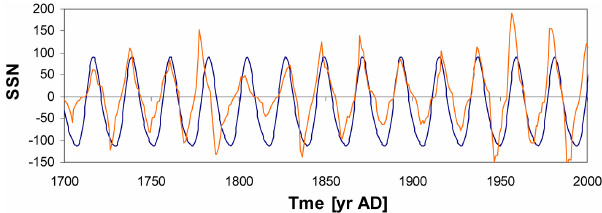
Figure B4. The double integral of the solar lateral inertial forces σF 2 ( t ) for the period from AD1000 to 3000. A polynomial trend is also depicted.